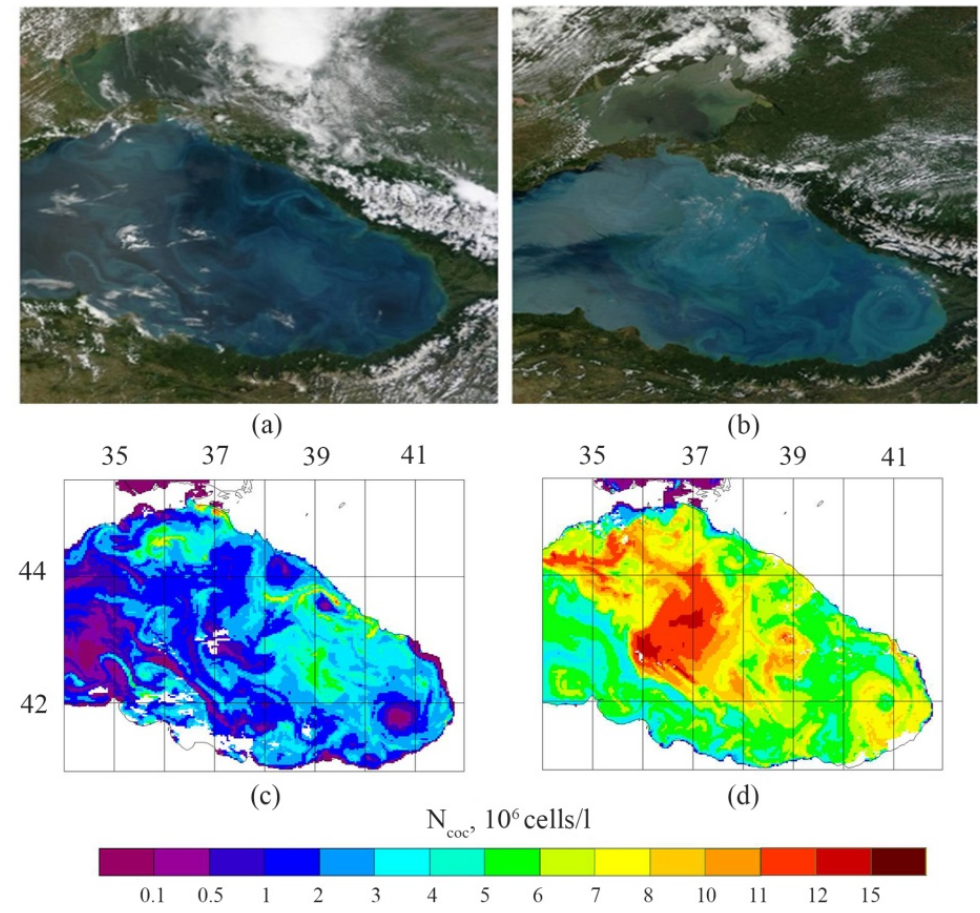
Figure 15. Development of coccolithophore blooms in the zone of the Batumi anticyclone in May and June 2012 according to the MODIS-Aqua; on the left—May (18 May 2012), on the right—June (18 June 2012) ( a , b )—true color images; ( c , d )—(N coc ) number of coccolithophores by the regional algorithm.